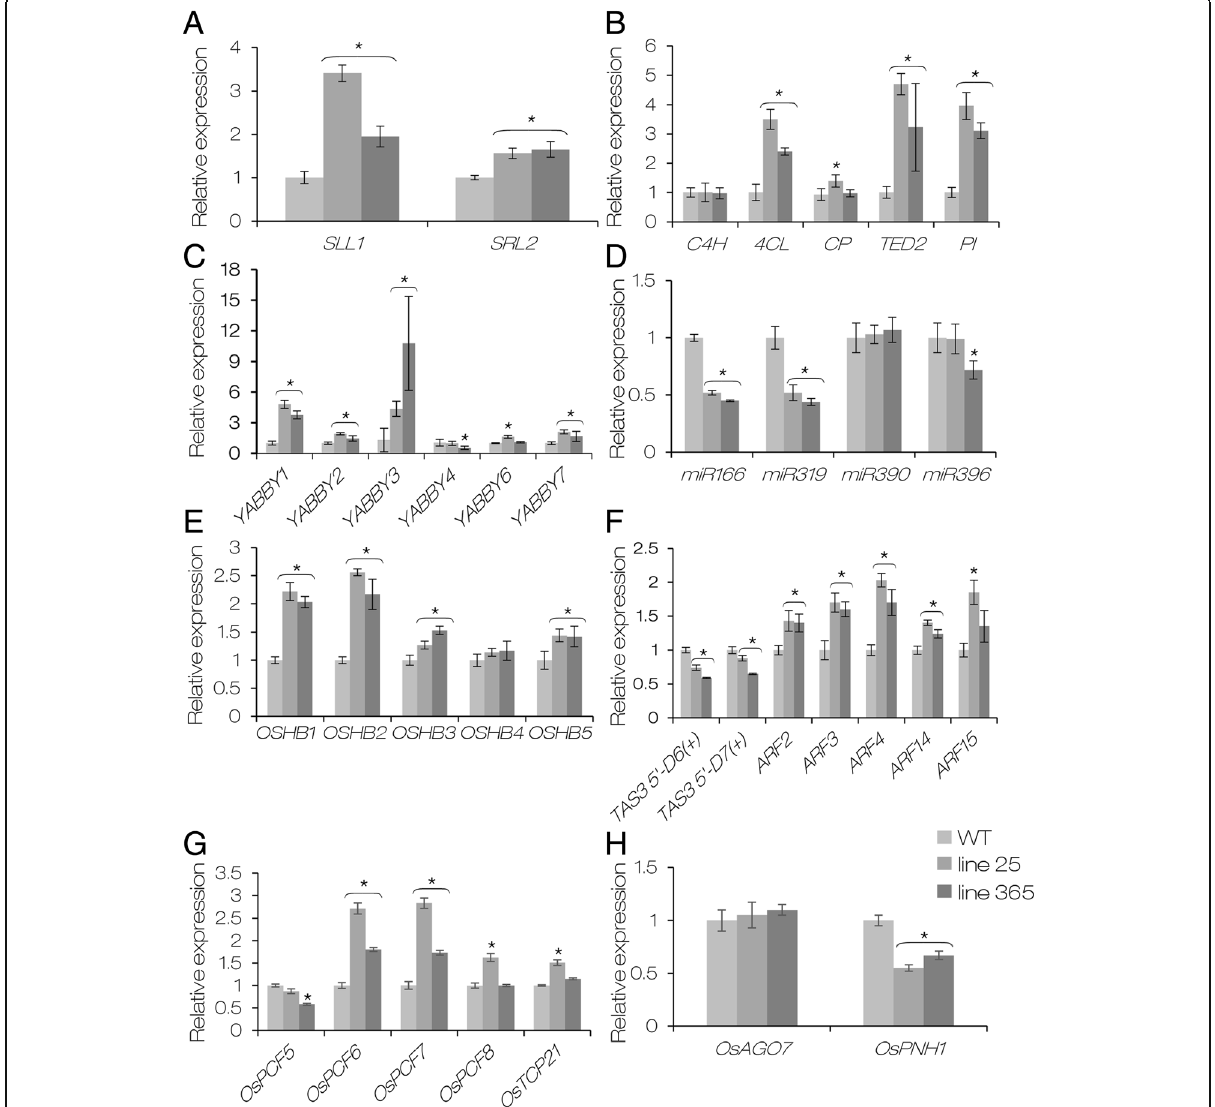
Fig. 8 Relative expression of genes and small RNAs related to sclerenchymatous cell development and leaf development. a Relative expression of SLL1 and SRL2 . b Relative expression of tracheary element-PCD related genes. C4H , cinnamate 4-hydroxylase ; 4CL , 4-coumarate:CoA ligase ; CP , Cys protease ; TED2 , tracheary element dehydrogenase 2 ; PI , protease inhibitor . c Relative expression of six rice YABBY genes. d Relative expression of four miRNAs related to leaf development. e Relative expression of OSHB family genes targeted by miR166. f Relative expression of two TAS3 -tasiRNAs and their targeted ARF genes. g Relative expression of miR319 targeted genes. h Relative expression of OsAGO7 and OsPNH1 involved in leaf development. The fourth leaves of 30-day-old seedlings from wild-type Zhonghua 11 (WT) and OE-AGO1b plants were used. The expression level of each gene was normalized to 1 in WT. OsActin1 (XM_015774830) and the 5S ribosomal RNA gene rrn5 (NC_011033.1282532..282653, complement) were used as internal standards to normalize the expression levels of genes and small RNAs, respectively. Error bars represent standard deviations among replicates ( n =3). * P <0.05 (one-way